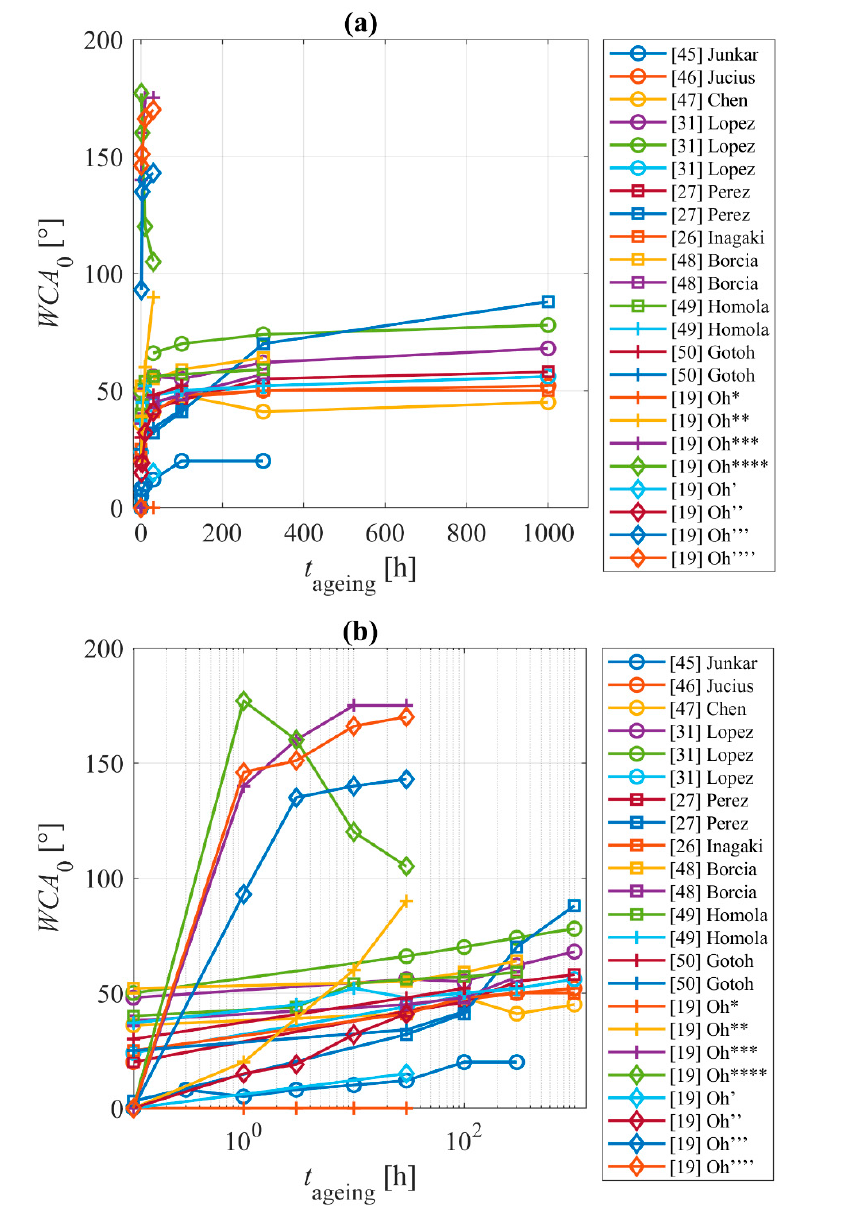
Figure 7. Temporal evolution of the WCA on plasma-treated PET with x-axis in linear scale ( a ) and in logarithmic scale ( b ).